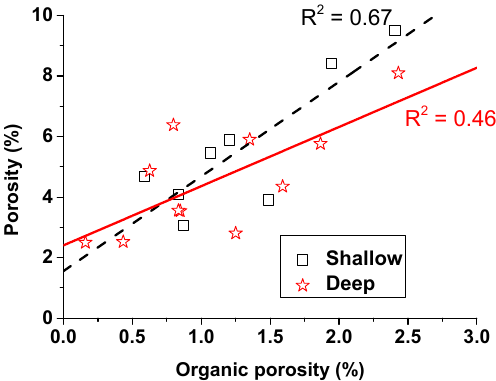
Figure 13. The correlation between porosity and organic porosity.